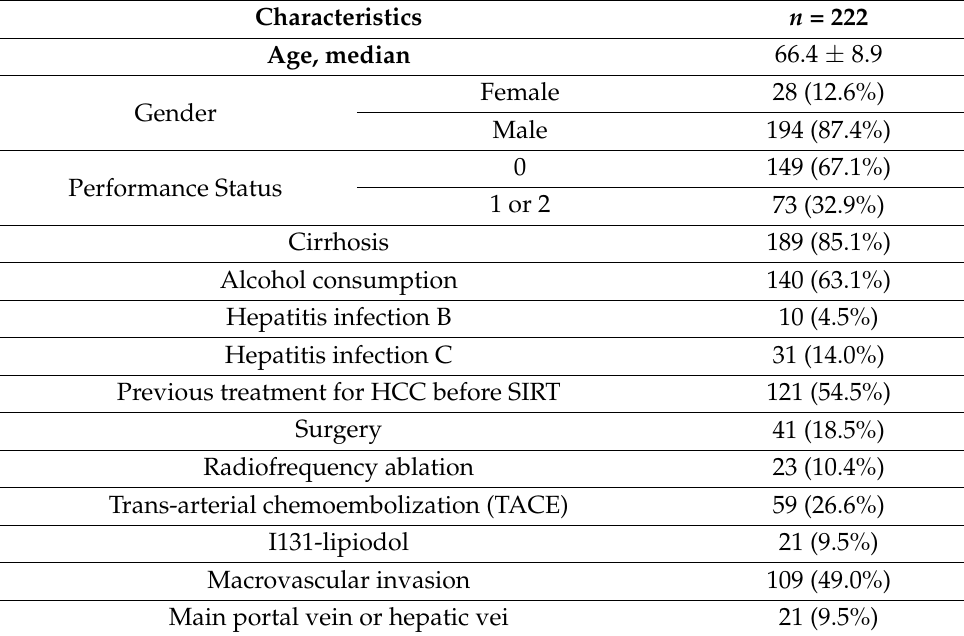
Table 1. Patients, tumors and treatment